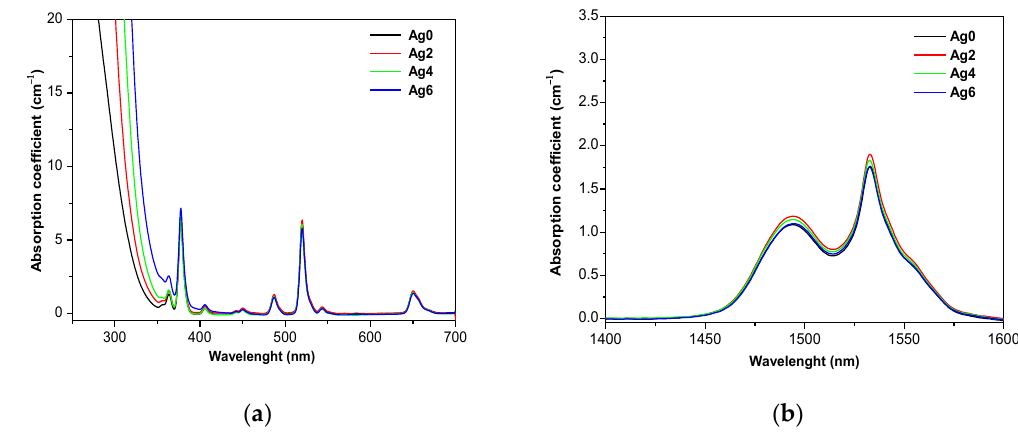
Figure 2. Absorption coefficient of the investigated glasses ( a ) in the UV – Vis and ( b ) IR